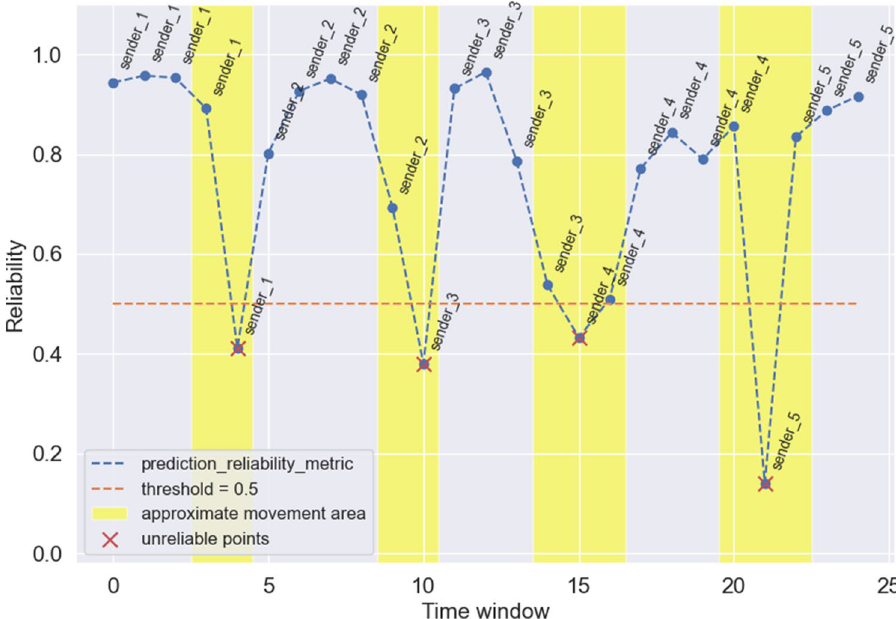
Figure 7. Filtering of unreliable proximity estimation results based on reliability metric over